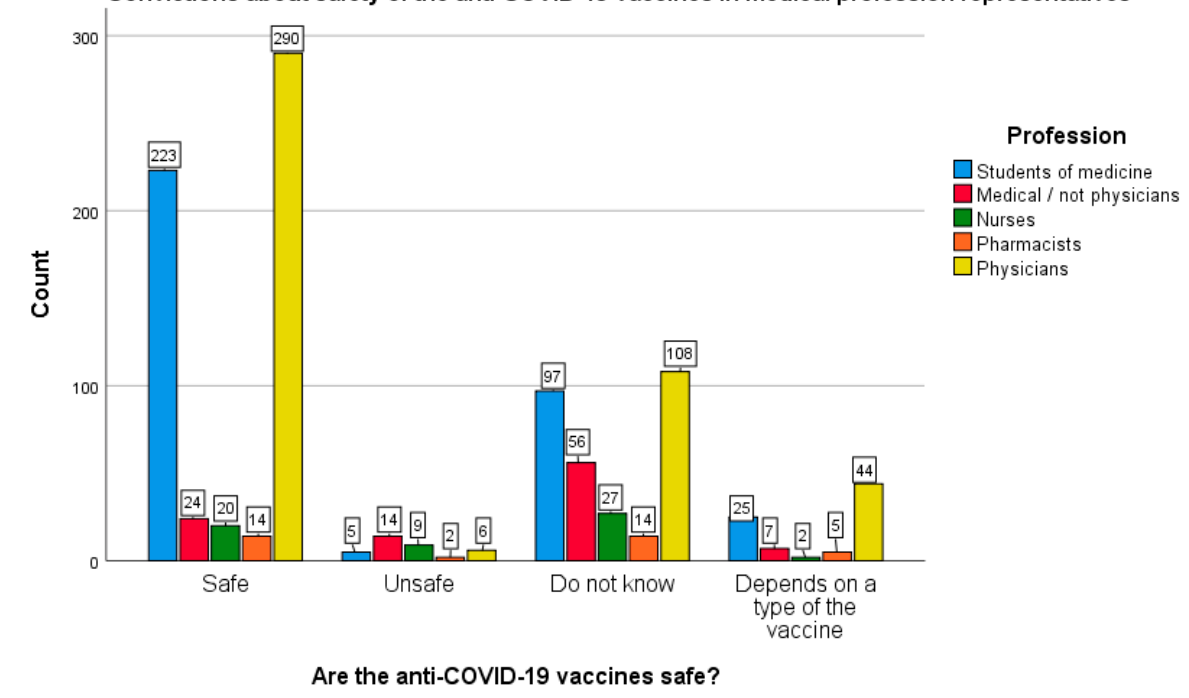
Figure 8. Beliefs about the safety of COVID-19 vaccines among representatives of medical profes- sionals.